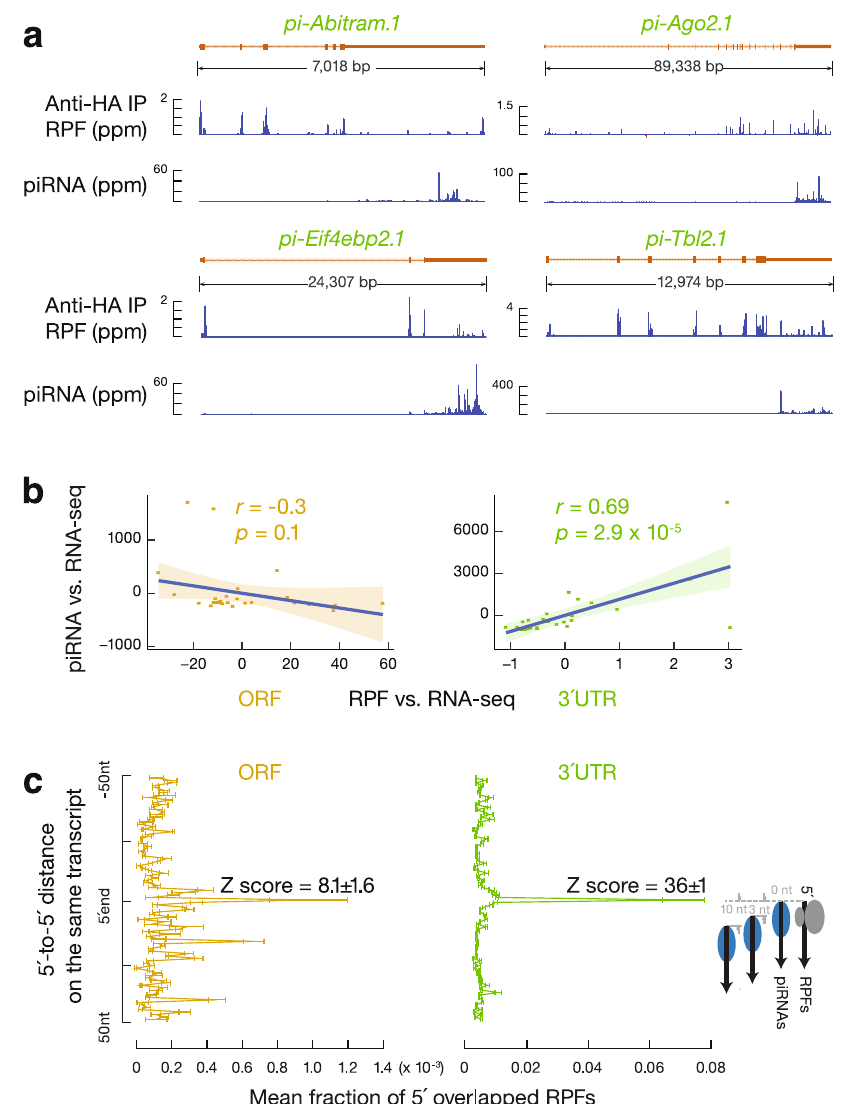
Fig. 3 3 ′ UTR ribosomes guide piRNA 5 ′ -end formation. a Normalized reads of anti-HA-immunoprecipitated RPFs and piRNAs mapping to four representative uppl genes in adult testes. b Residual plot of partial correlation between piRNA and RPF abundance conditional on RNA-seq abundance at the uppl ORFs (left) and 3 ′ UTRs (right) in adult testes. Linear regression was performed between piRNA and RNA-seq abundance and between RPF and RNA-seq abundance separately, and residuals were plotted with smooth parameter “ method = lm ” . Data are presented as mean values ± standard deviation shown as error bands. c Distance spectrum of 5 ′ -ends of RPFs (26 – 32 nts) from ORFs (left) and from 3 ′ UTRs (right) that overlap piRNAs in adult testes (sample size n = 3 independent biological replicates). Data are mean ± standard